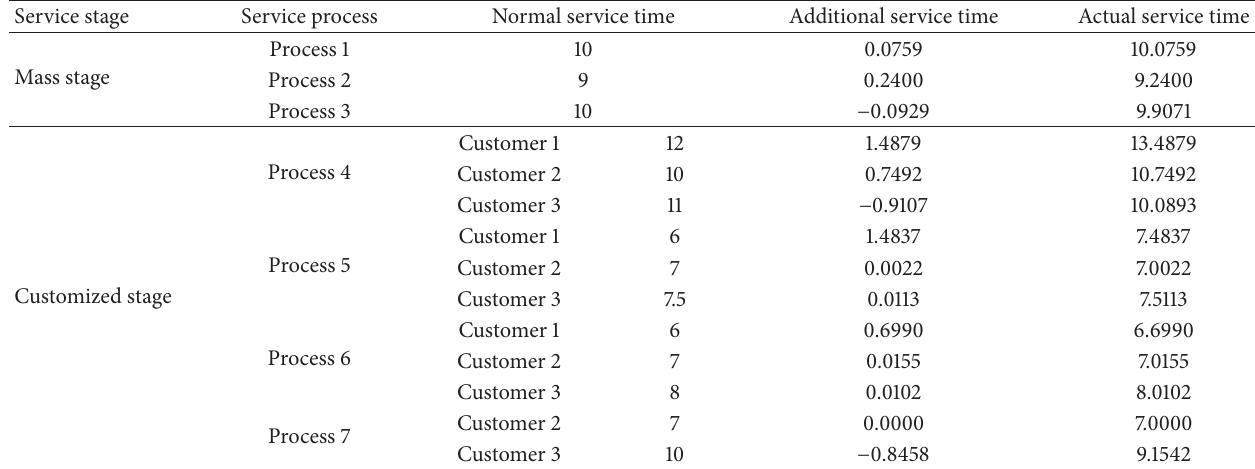
Table 3: Results of numerical example calculation.